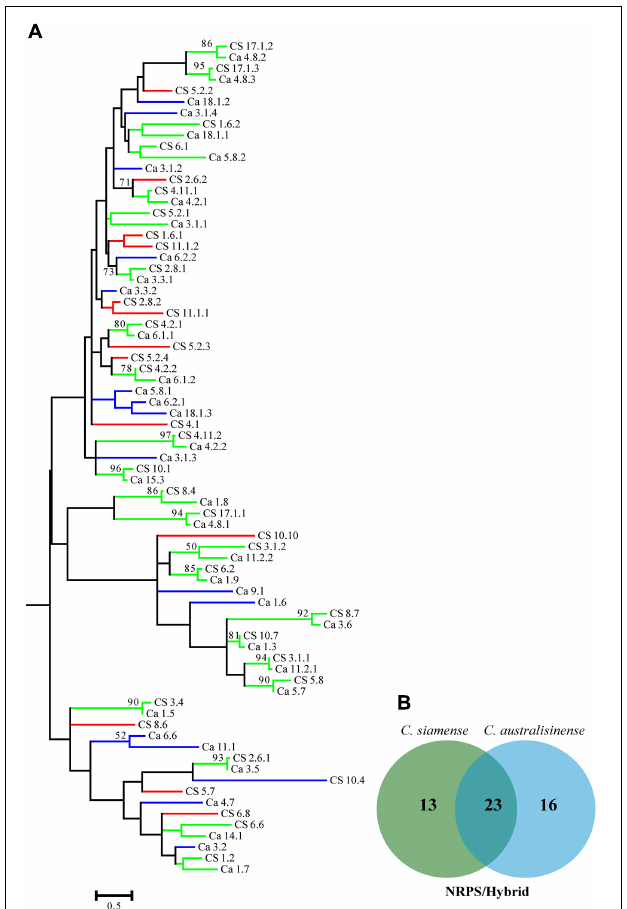
FIGURE 6 | (A) Phylogenetic tree of the adenylation domain (A domain) amino acid sequences of putative NRPS and PKS-NRPS hybrids. Sequences were aligned using MEGA 6.0, and the phylogenies inferred by maximum-likelihood (as calculated by the LG + G Model) in MEGA 6.0. The numbers on branch nodes indicate support values above 50%. Red branches show the A domain of Colletotrichum siamense only; blue branches show the A domain of C. australisinense only; green branches the A domain shared by both species. (B) Venn diagram summarizing the numbers of conserved and non-conserved sequences between the two fungal